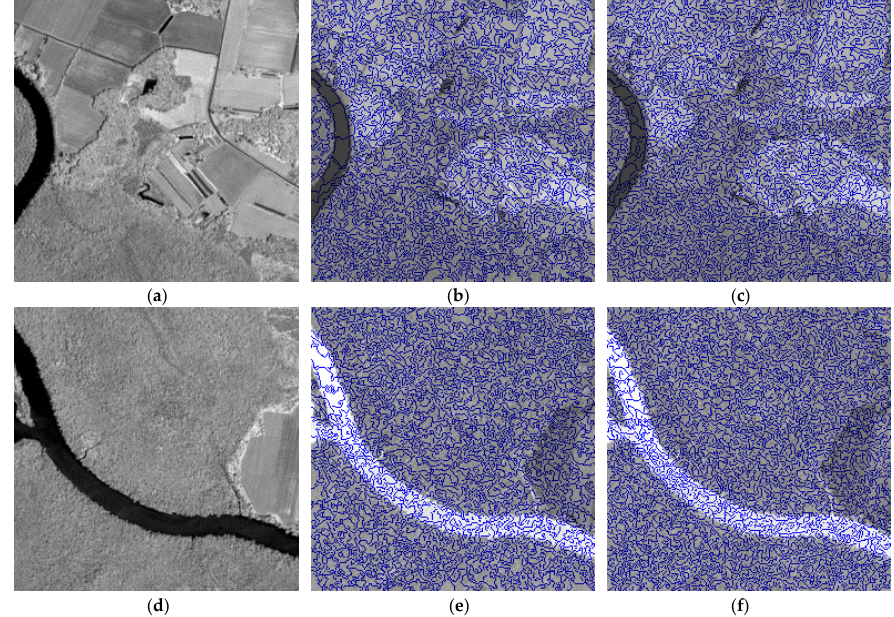
Figure 17. Sub ‐ datasets of low altitude in the 60th band: (a) covered by complex ground objects; (b) Figure 17. Sub-datasets of low altitude in the 60th band: ( a ) covered by complex ground objects; superpixel segmentation ( K = 500), (c) superpixel segmentation ( K = 1000), (d) covered by simple ( b ) superpixel segmentation ( K = 500), ( c ) superpixel segmentation ( K = 1000), ( d ) covered by simple ground objects, (e) superpixel segmentation ( K = 500), (f) superpixel segmentation ( K = 1000). ground objects, ( e ) superpixel segmentation ( K = 500), ( f ) superpixel segmentation ( K =